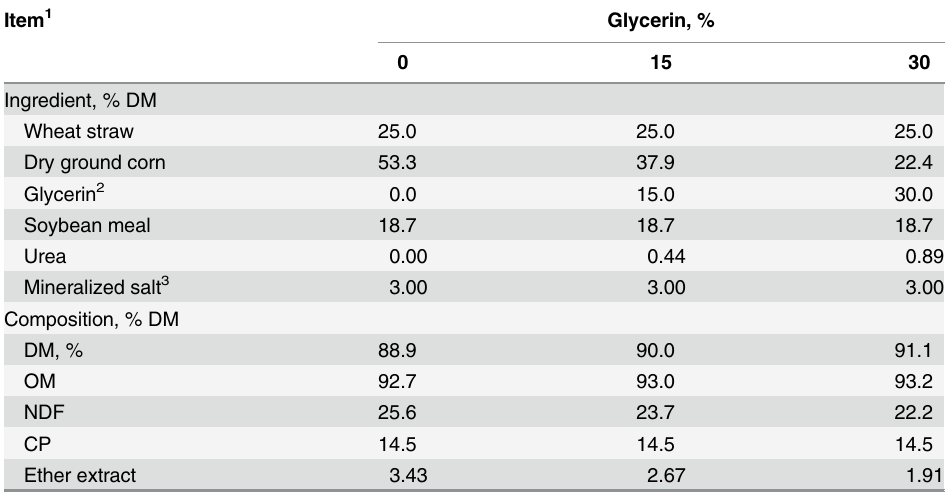
Table 1. Ingredient and chemical composition of experimental